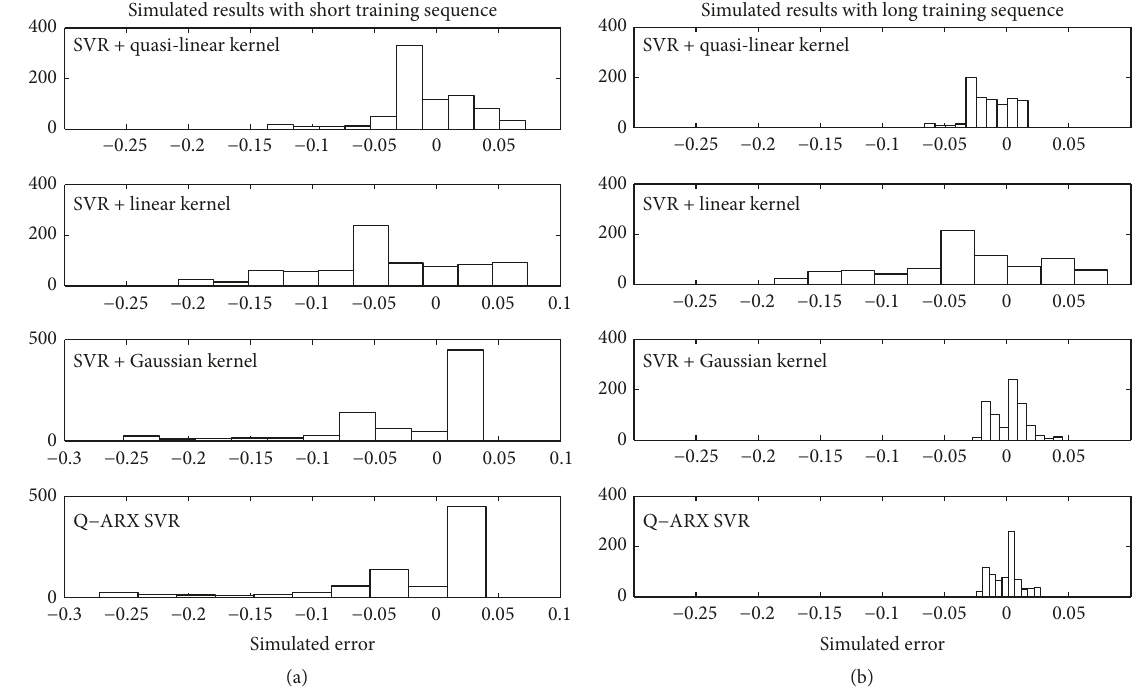
Figure 7: Histograms of the simulated errors. The horizontal coordinate in each subfigure denotes the simulated error of the model, whose elements are binned into 10 equally spaced containers. Four models are trained by using both short (a) and long (b) training sequences, then the simulated performance variation can be investigated by